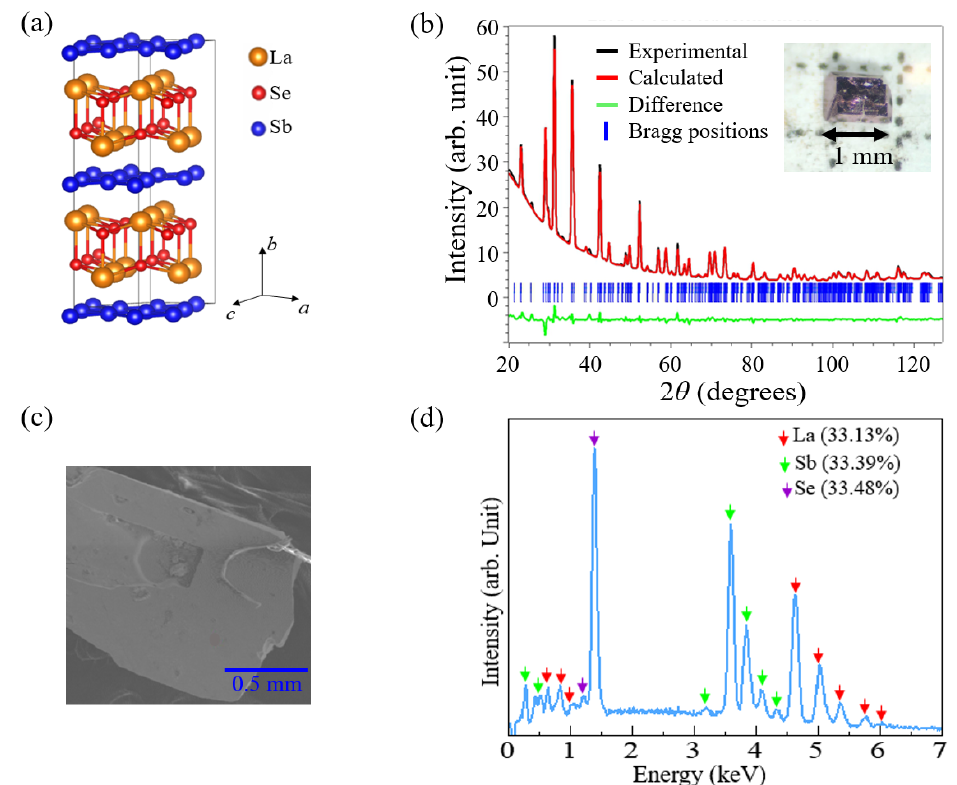
Figure 1. ( a ) Crystal structure of LaSbSe. ( b ) Powder XRD pattern and refinement for LaSbSe. Powder sample was obtained by grounding single crystals. Inset: image of a LaSbSe single crystal. ( c ) Scanning electronic microscopy (SEM) image of a LaSbSe single crystal. ( d ) Energy dispersive spectroscopy (EDS) spectrum of the LaSbSe single crystal shown in ( c ). The obtained composition is La 0.992 Sb 1.000 Te 1.003 .